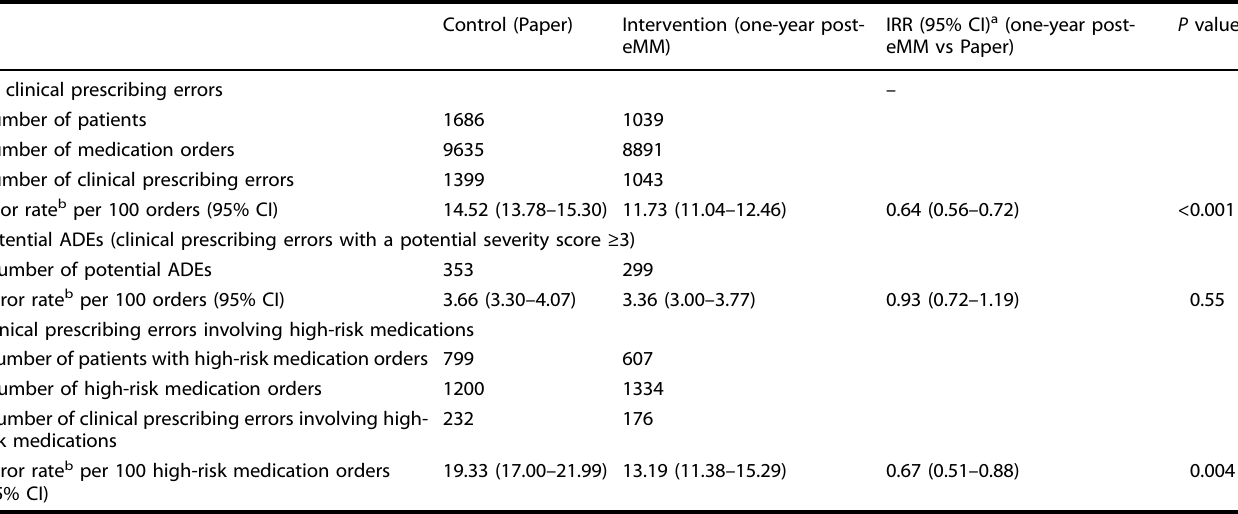
Table 3. Prescribing error rates and adjusted incidence rate ratios (IRRs) comparing control and one-year post-eMM